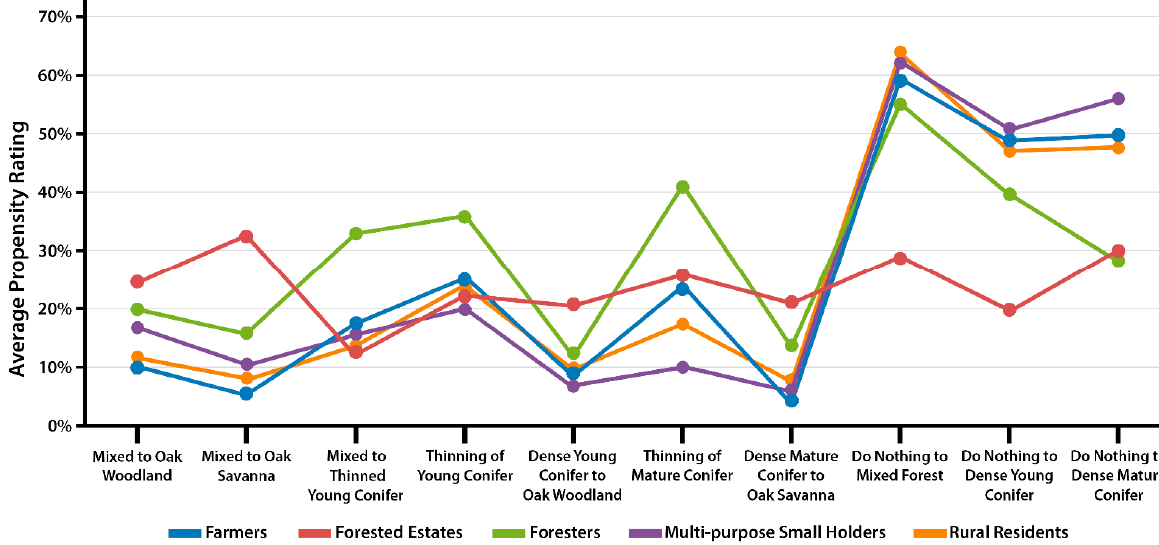
Figure 8. Average fuels reduction propensities across project options by landowner types.